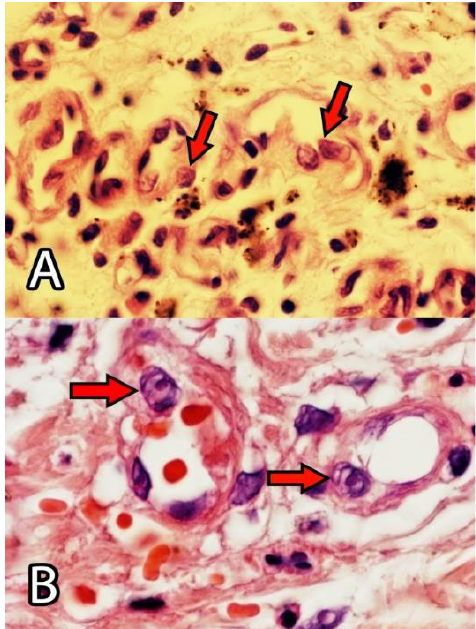
Fig. 1. Swollen endothelial cells with prominent nucleoli of vessels in the alveolar interstitial space (A) and skin (B);